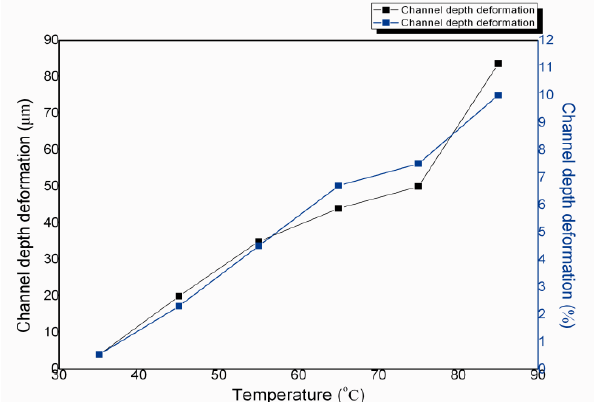
Figure 12. The relationship between bonding temperature and channel depth